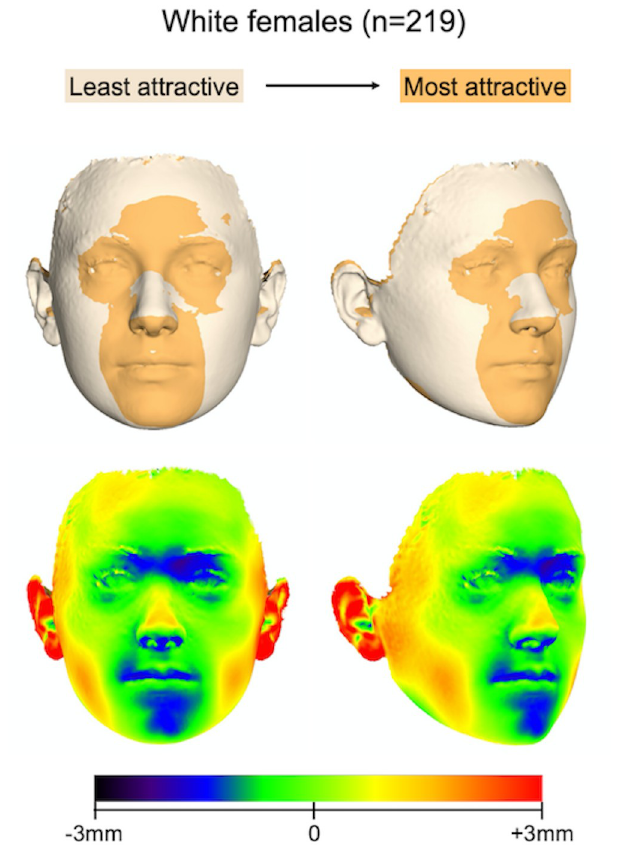
Fig 8. Best fit superimposition showing the surface differences between the least and most attractive variation of a white female (upper row) face. The magnitude of difference between the two surface images can be visualized on the color maps (lower row), where distances between the most attractive and the least attractive face are shown (positive: forward).